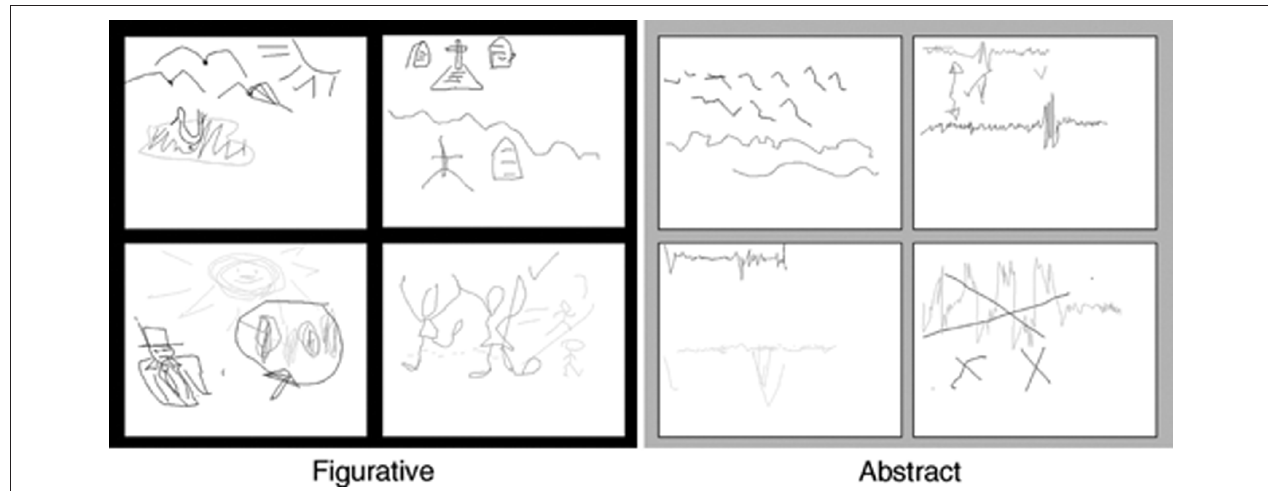
Figure 7 | examples of drawings from Healey et al. (2007) reflecting either Figurative (left) or Abstract (right) properties of the music being